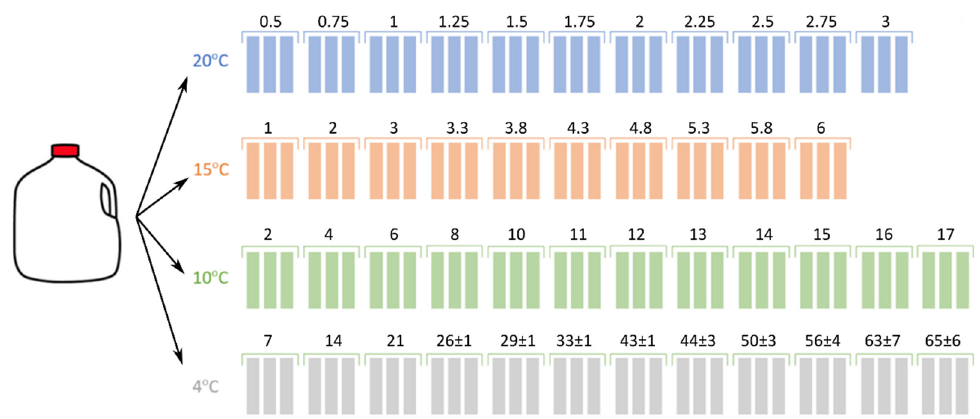
Figure 4. Sample collection times (days) for each storage temperature. Shown are means ± standard errors (omitted if equal to zero).